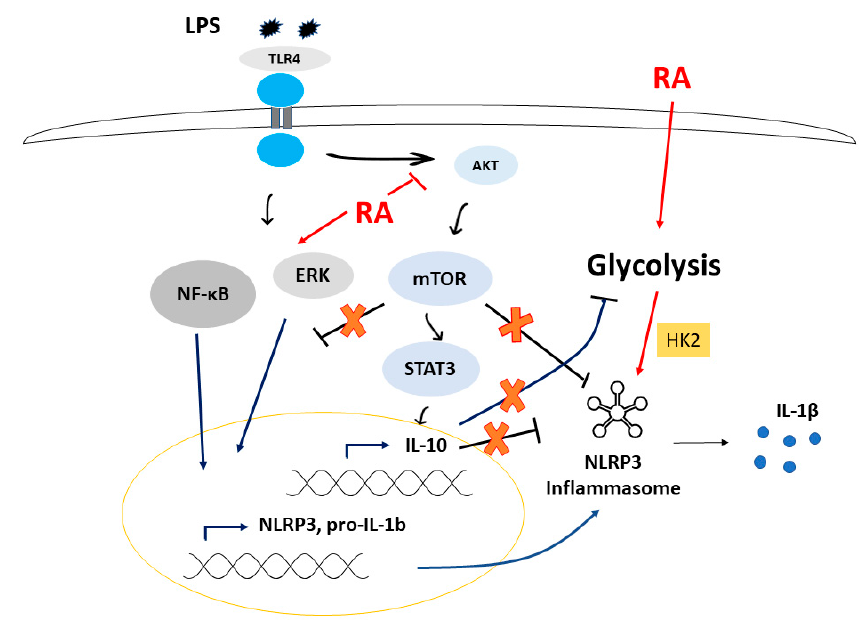
Figure 8. Proposed model for the e ff ects of